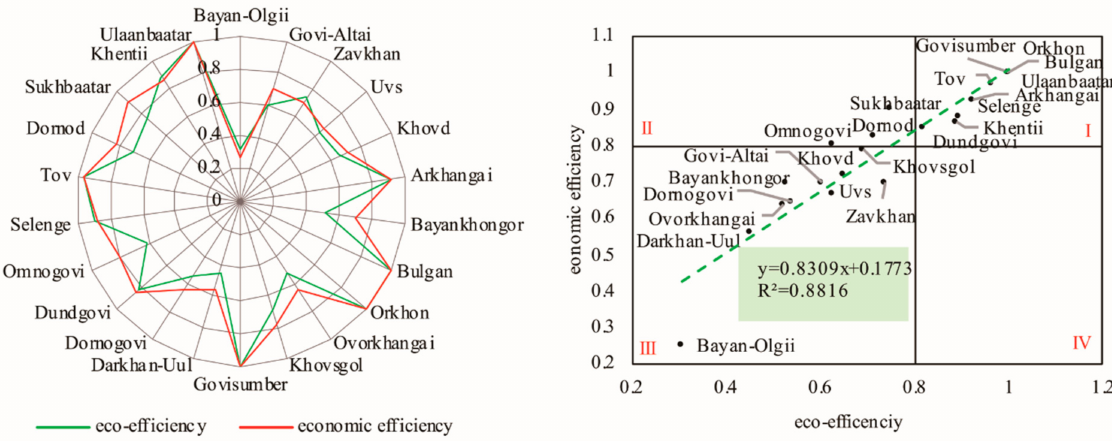
Figure 6. Coupling relationship of eco-efficiency and economic efficiency in Mongolia from 2007 to